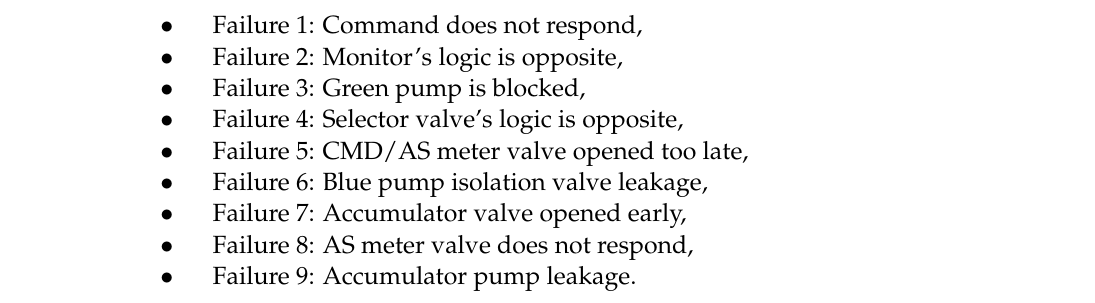
propagation paths, the fault tree of the brake system can be obtained, as shown in Figure 9. The propagation of single failure is represented by an OR gate in the fault tree, while the propagation of double failure is represented by an AND